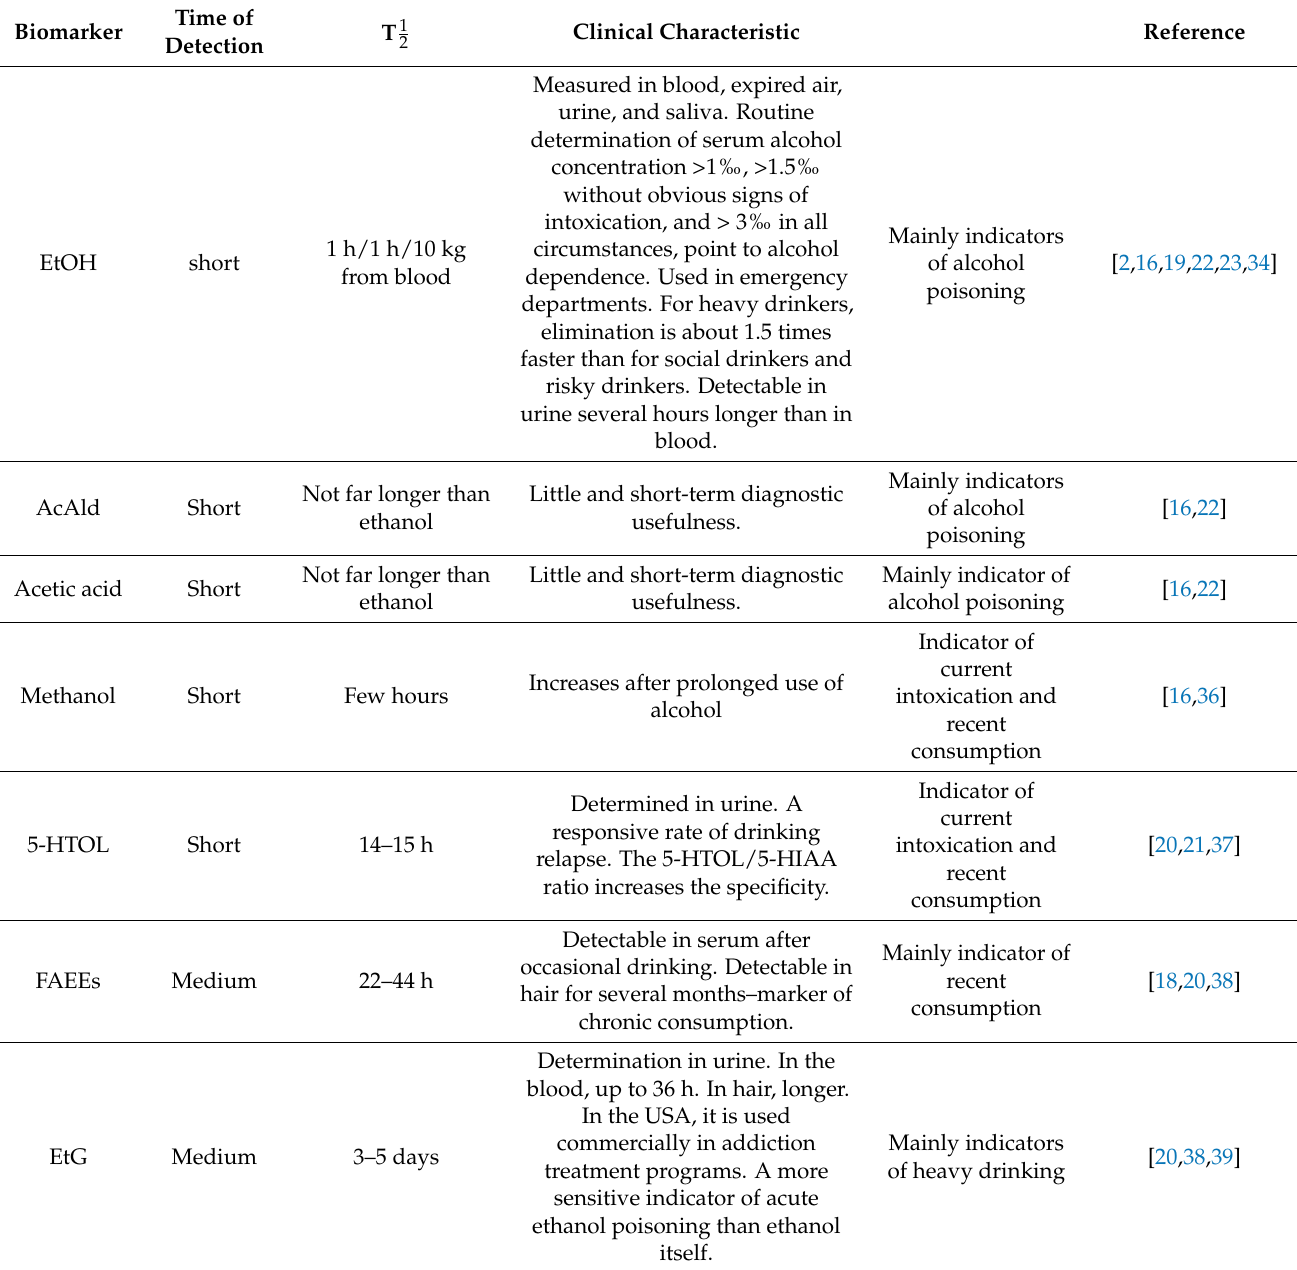
Table 3. Biomarkers of alcohol abuse with short, intermediate, and long half-lives. Short-range, mid- range, and long-range biomarkers of alcohol abuse. EtOH, ethanol; AcAld, acetaldehyde; 5-HTOL, 5-hydroxytryptofol; 5-HTOL/5-HIAA, 5-hydroxytryptofol/5-hydroxyindole acetic acid indicator; FAEEs, fatty acid ethyl esters–fatty acid ethyl esters; EtG, ethyl glucuronide–ethyl glucuronate; PEth, phosphatidyl ethanol–phosphatidylethanol; EtS, ethyl sulfate–sulfuric acid ethyl esters; AA, acetaldehyde adducts–acetaldehyde adducts; WBAA–whole-blood-associated acetaldehyde; HAA– hemoglobin-associated acetaldehyde; β -HEX, β -hexosaminidase; SA, sialic acid–sialic acid; MCV, mean corpuscular volume–mean red blood cell volume; GGT, gamma-glutamyl transferase; AST and ALT, -aspartate and -alanine aminotransferases; CDT, carbohydrate-deficient transferrin–low- carbohydrate isoforms of